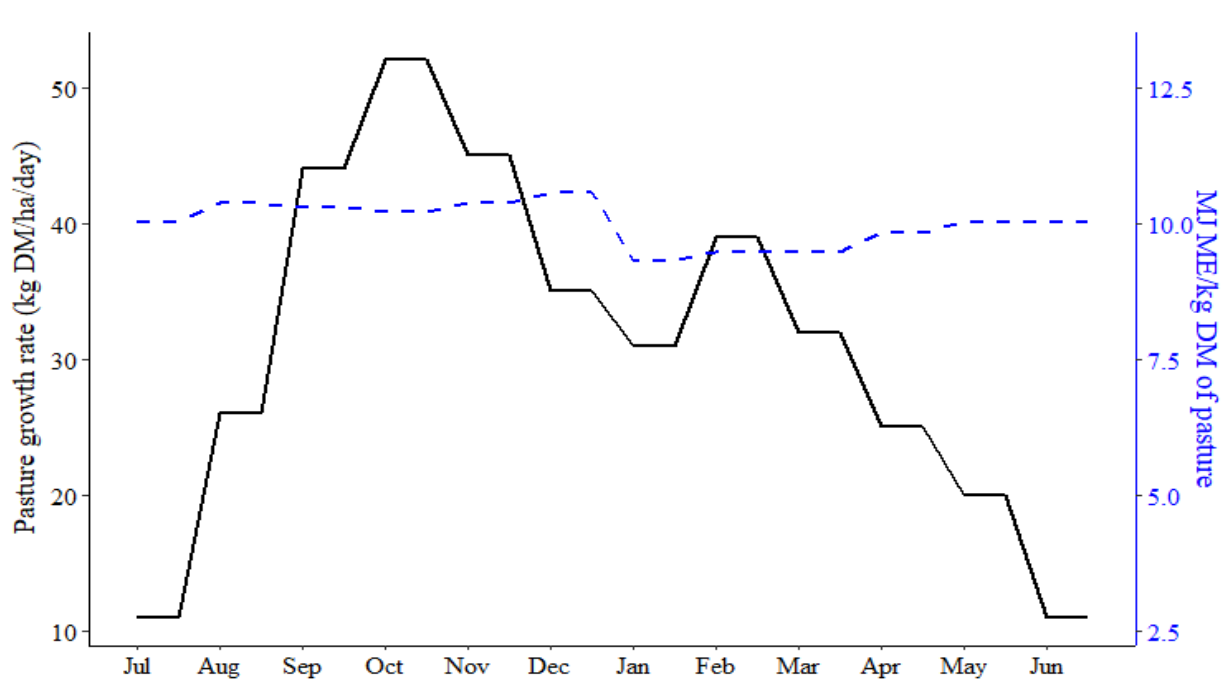
Figure 2. Bi-monthly average pasture growth rate kg DM/ha/day (left axis and black solid line) and MJ ME/kg DM of pasture (right axis and blue dashed line). Sources: [47,52].